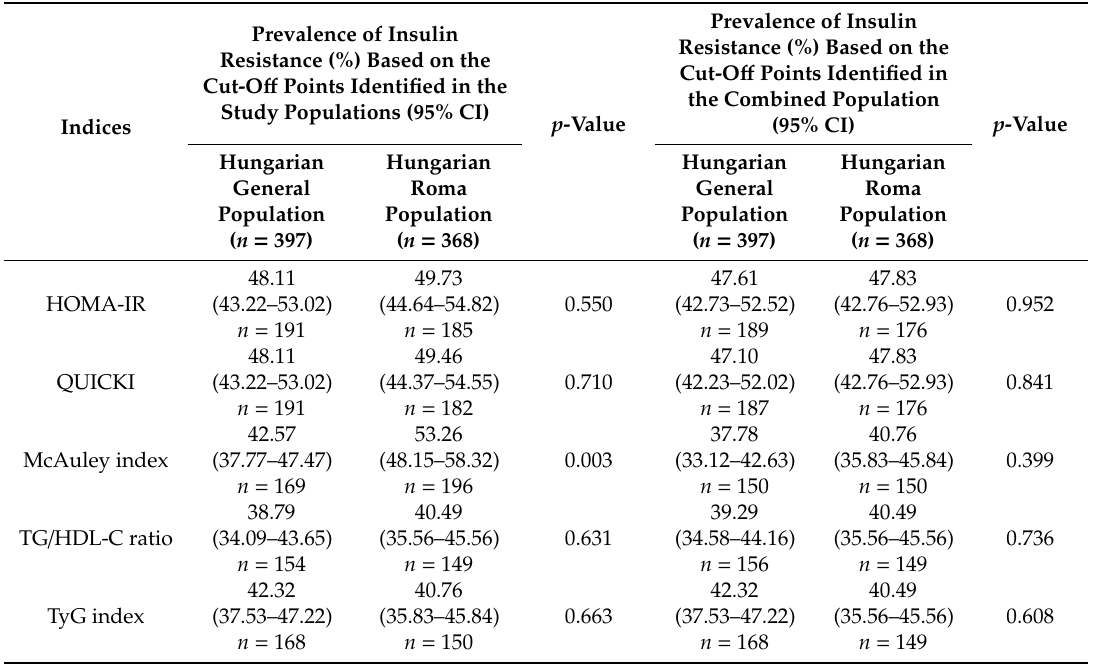
Table 6. Prevalence of insulin resistance (IR) and number of persons with IR in the Hungarian general and Hungarian Roma